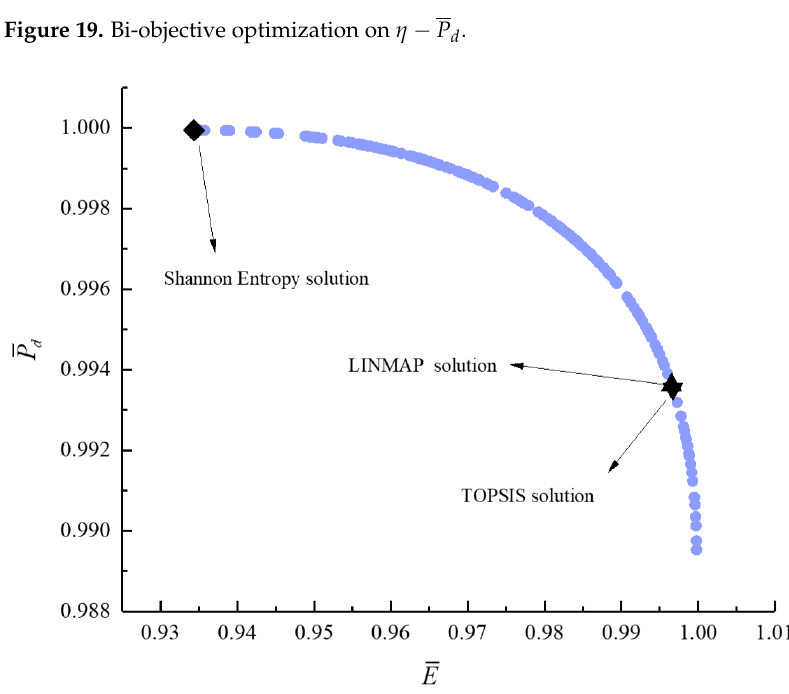
Figure 20. Bi-objective optimization on E − P d